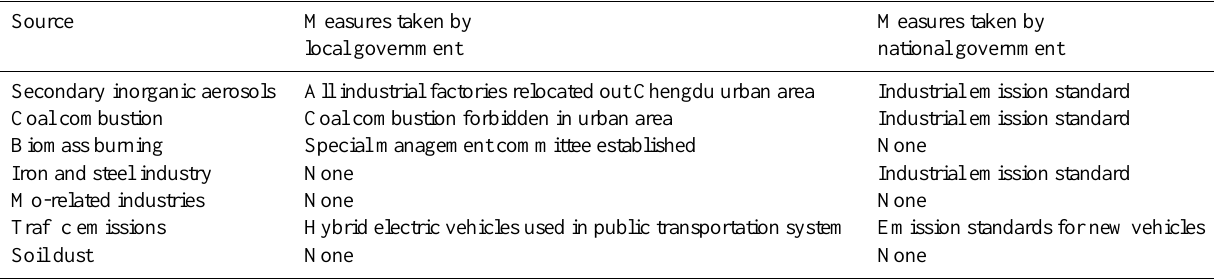
Table 5. Summary of measures taken by local and national government in